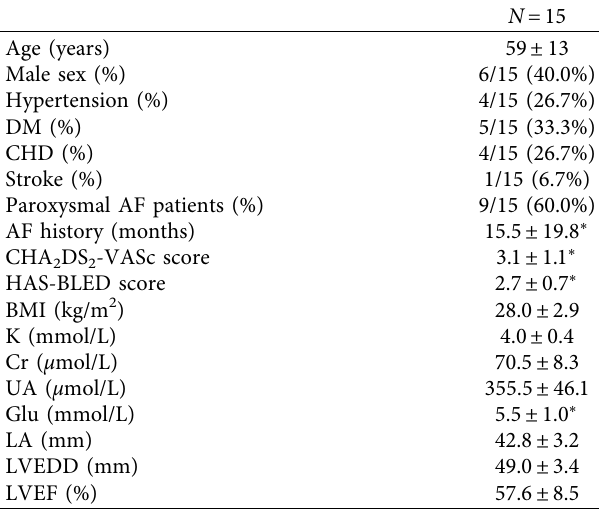
Table 1: Baseline clinical characteristics of the study population.